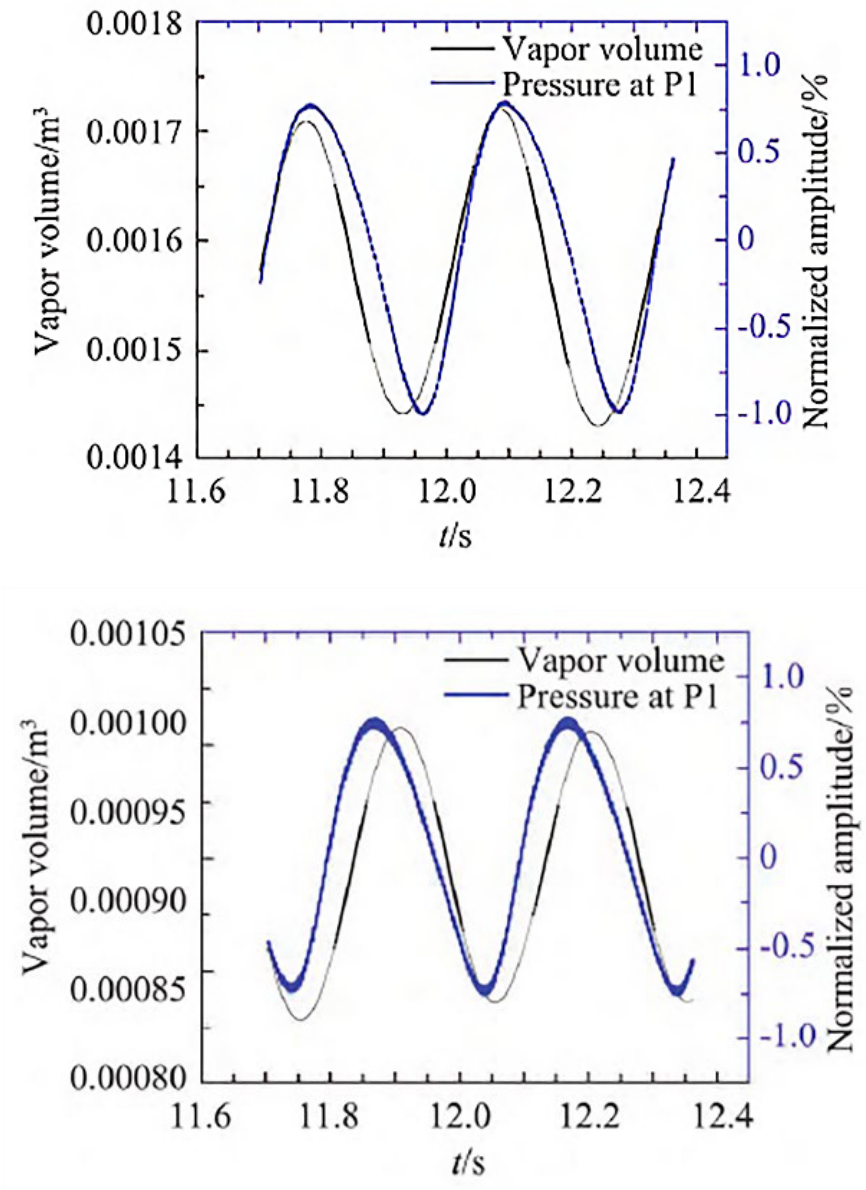
Figure 11. Volume change of hollow bubbles in draft tube [62].